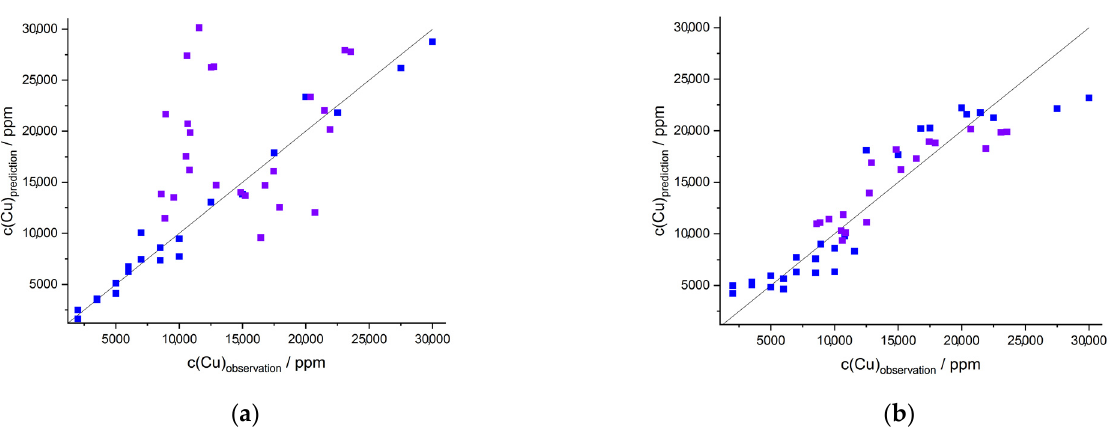
Figure 9. ( a ) PLSR (4 components) of the synthetic samples (Cu 2 S and CuFeS 2 in schist; dark blue) applied to the Polish field samples (purple): R² V = − 1.95, RMSEV = 8228 ppm; ( b ) PLSR (4 components) of the synthetic samples (Cu 2 S and CuFeS 2 in schist) and 22% of the field samples (dark blue) applied to the Polish field samples (purple): R² V = 0.79, RMSEV= 2180 ppm; all measured on Echelle spectrometer. Table 5. Validation results (R², RMSE) of PLSR of the synthetic samples in schist validated with the Polish field samples.